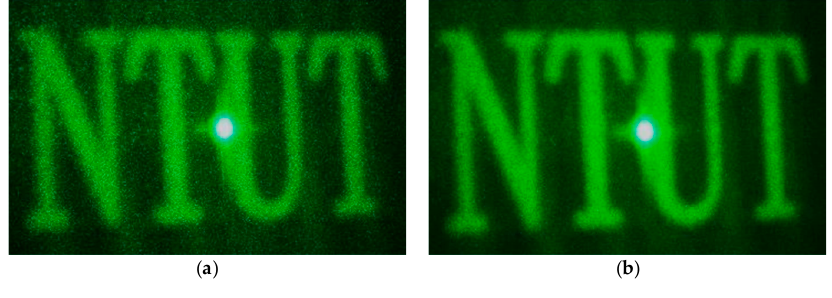
Figure 6. Cont. Figure 6.